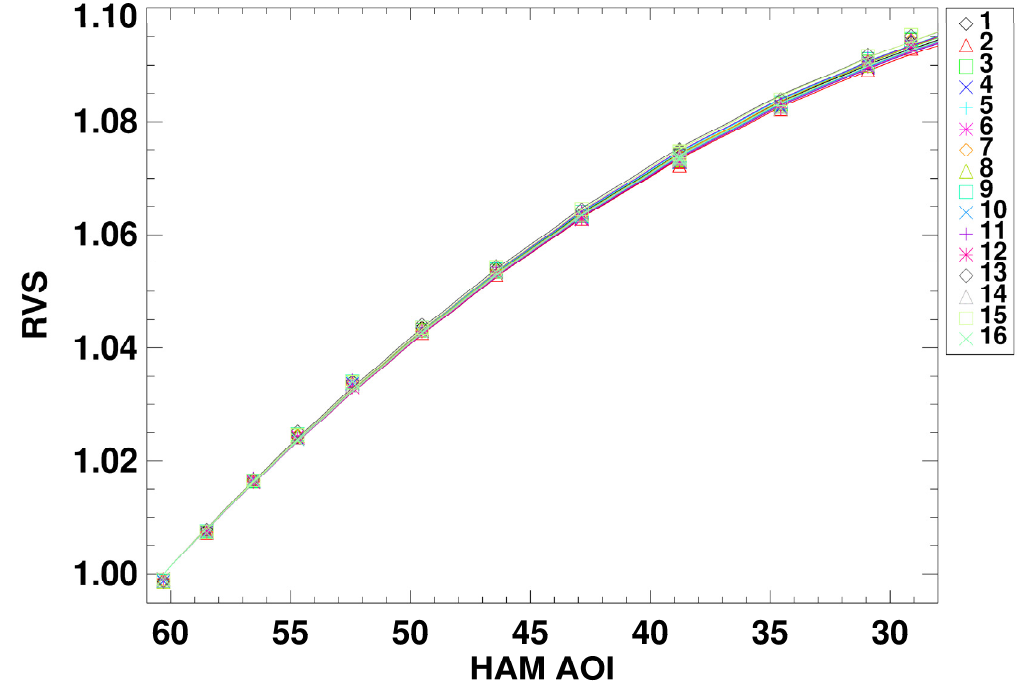
Figure 14. Band M14 HAM side A RVS Response and Fits for all Detectors.